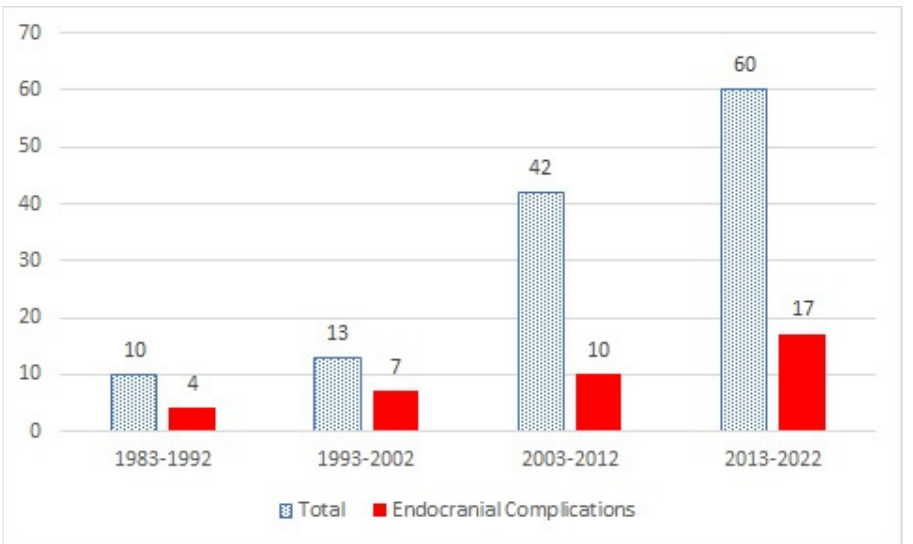
Figure 2. Bar diagram showing reported patients and intracranial complications by decades (1983–